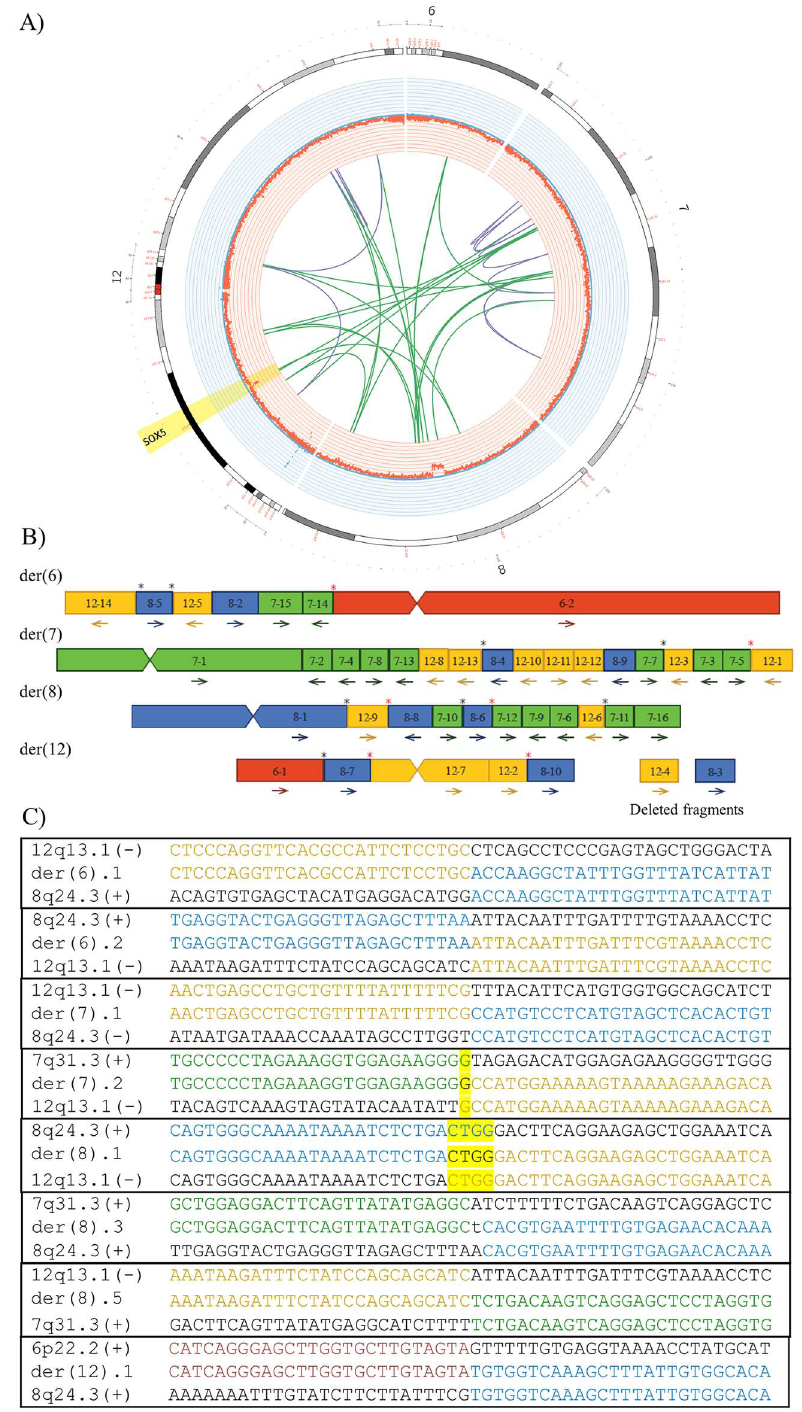
Fig 2. Summarized WG-MPS and Sanger sequencing results in Case 2. A) Circos plot illustrating partial chr6, chr7, chr8, and chr12 ideograms (outer circle), deletions (red) and duplications (blue) based on the depth of coverage analysis (inner circle) as well as inter-translocation (green lines) and intra-translocation (purple lines) junctions identified by WG-MPS in Case 2. SOX5 disruption by a heterozygous deletion and two inter-translocation breakpoints is highlighted. B) Derivative chromosome reconstruction of the chromothripsis rearrangement. Fragments from chromosomes 6, 7, 8, and 12 are in red, green, blue, and yellow, respectively. Arrows: fragment orientations; black